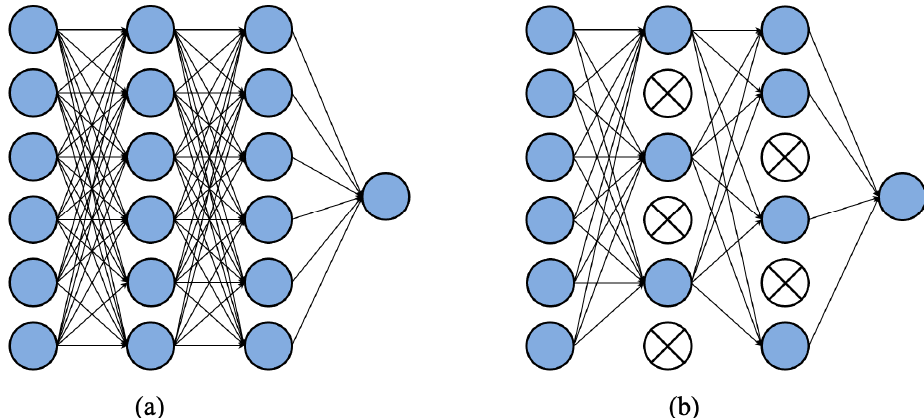
Figure 4. The structure flow chart of DropOut. ( a ) Is the standard neural network structure. In ( b ), some neurons are randomly deleted using dropout.